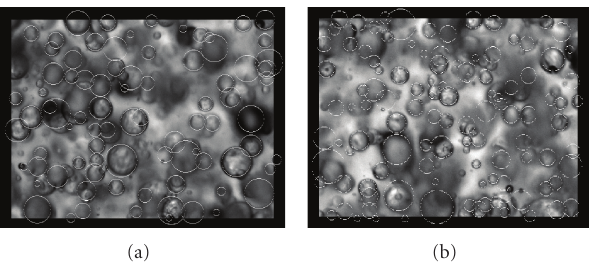
caused by agglomerates of pixels in the contour of the drops. However, the detection is not e ffi cient for radii below 8 pixels (0.08